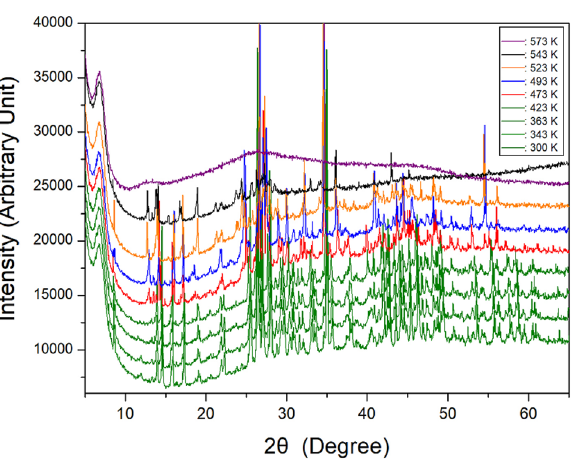
Figure 3. Powder x-ray diffraction patterns of [NH 3 (CH 2 ) 2 NH 3 ] 2 CdBr 4 ·2Br at different